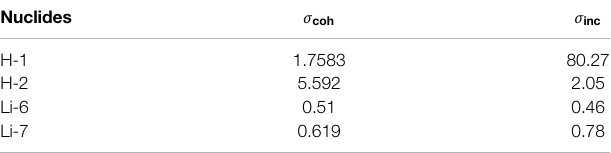
TABLE 1 | Bound scattering cross sections for several